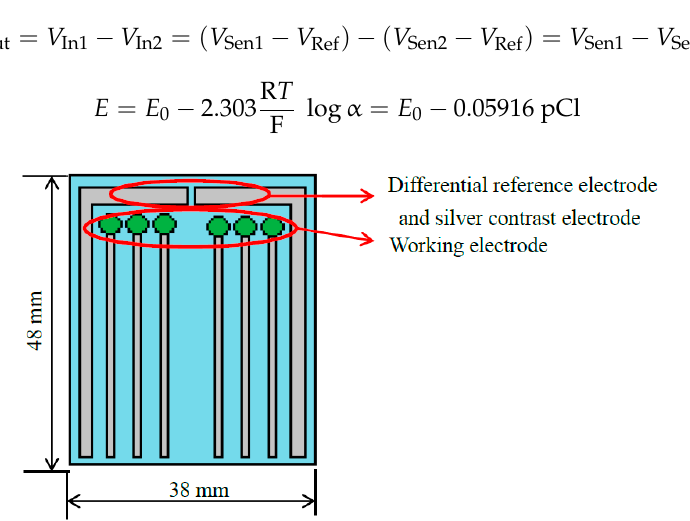
Figure 3. The schematic diagram of the arrayed flexible RuO 2 /GO chloride sensor [14].